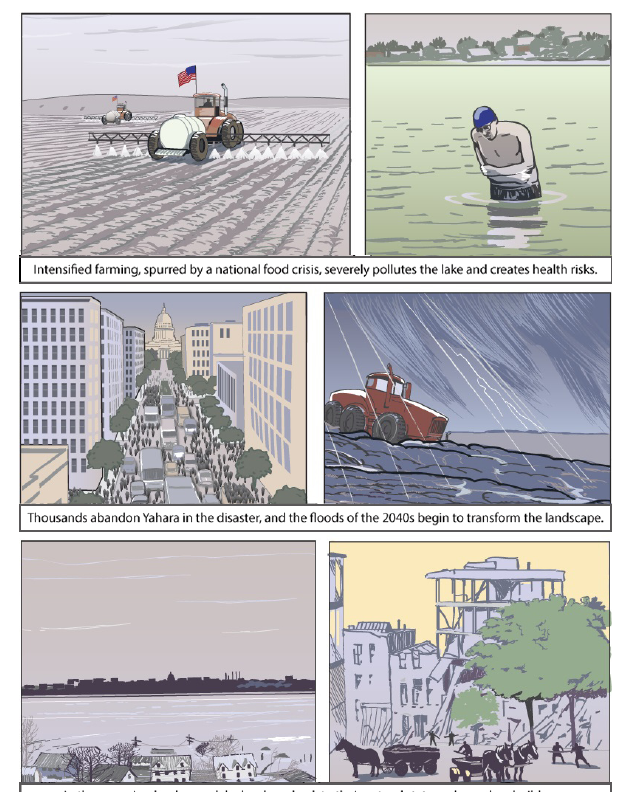
Fig. 5. Timeline of major events during the “Abandonment and renewal”